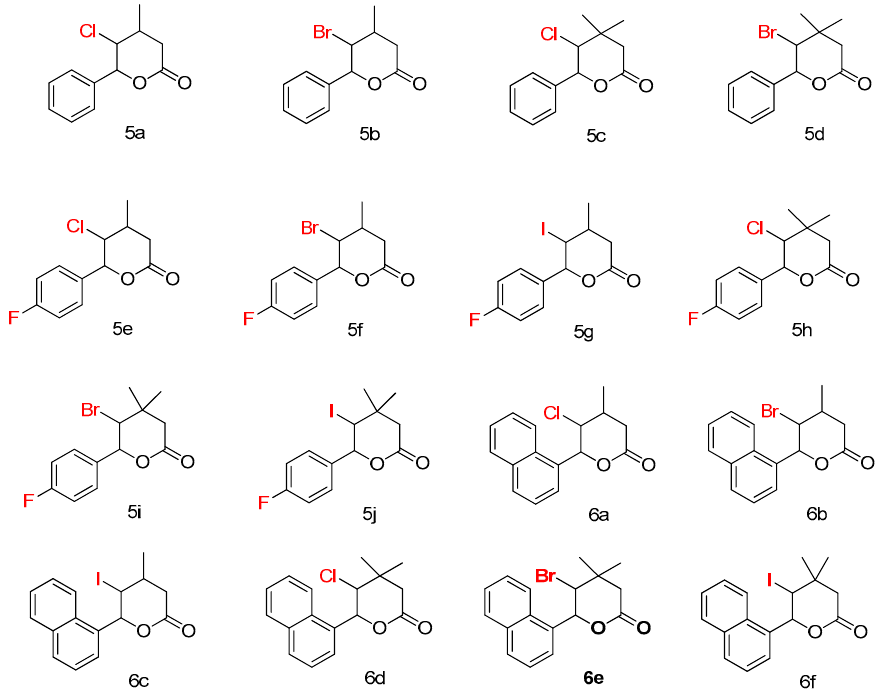
Figure 3. The chemical structure of δ -lactones obtained. The specific substituents that determine the reactivity of the compounds are marked in red. Table 1. Yields of reaction provided for isolated pure